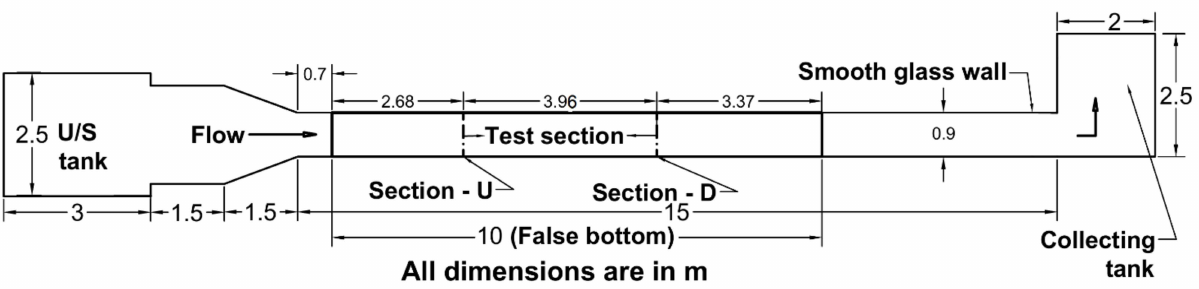
Figure 1. Experimental setup plan